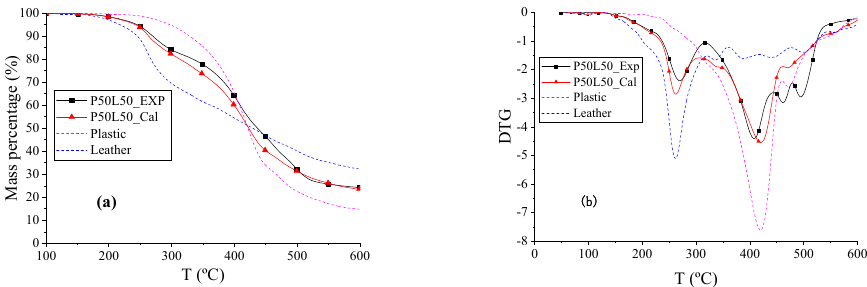
Figure 5. The TG and DTG thermograms of P, L, and P50L50. ( a ) TG thermograms reflects the change in mass percentage during pyrolysis process. ( b ) DTG thermograms refer to the derivative curves of TG thermograms.